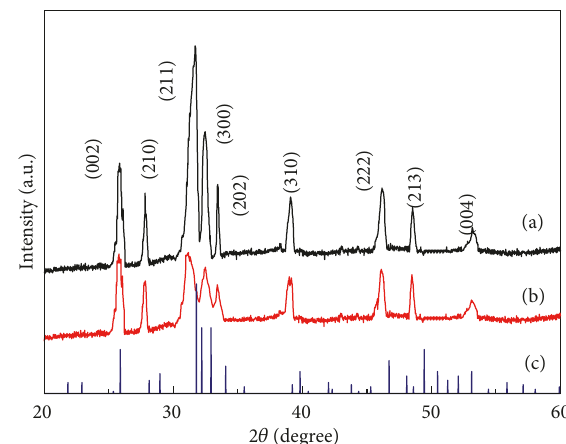
Figure 3: FTIR spectra of the samples. (a) FA; (b) aminated hydrox- yapatite; (c) FA-grafted hydroxyapatite.